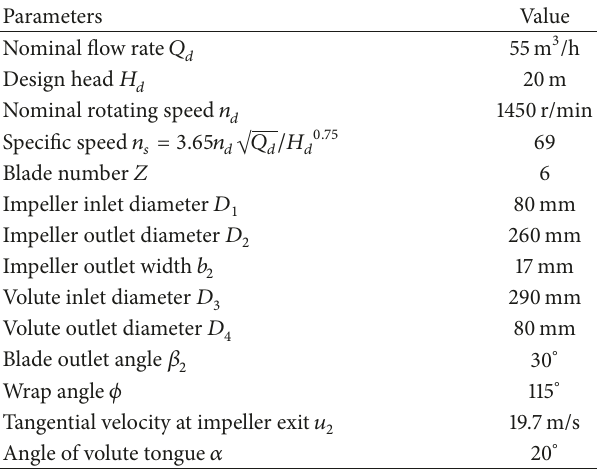
Table 1: Main design parameters of the model